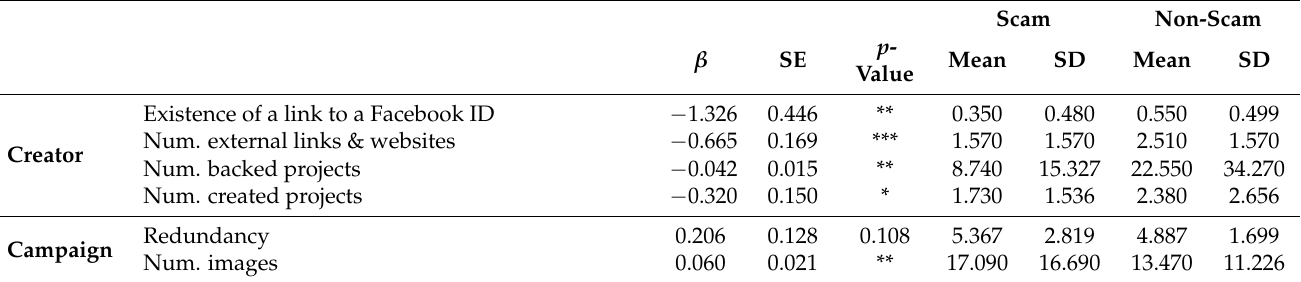
Table 2. Key features selected by Logistic Regression for scam detection and their descriptive